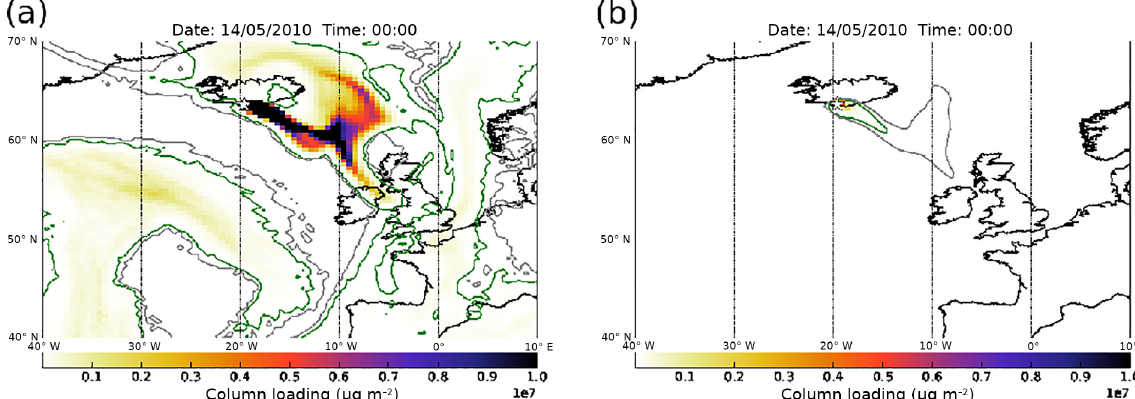
Figure 6. NAME ash column loading for parameter choices with the highest and lowest expected ash column loadings in the first geographical region at 00:00UTC on 14 May. The contours are as in Fig. 2.